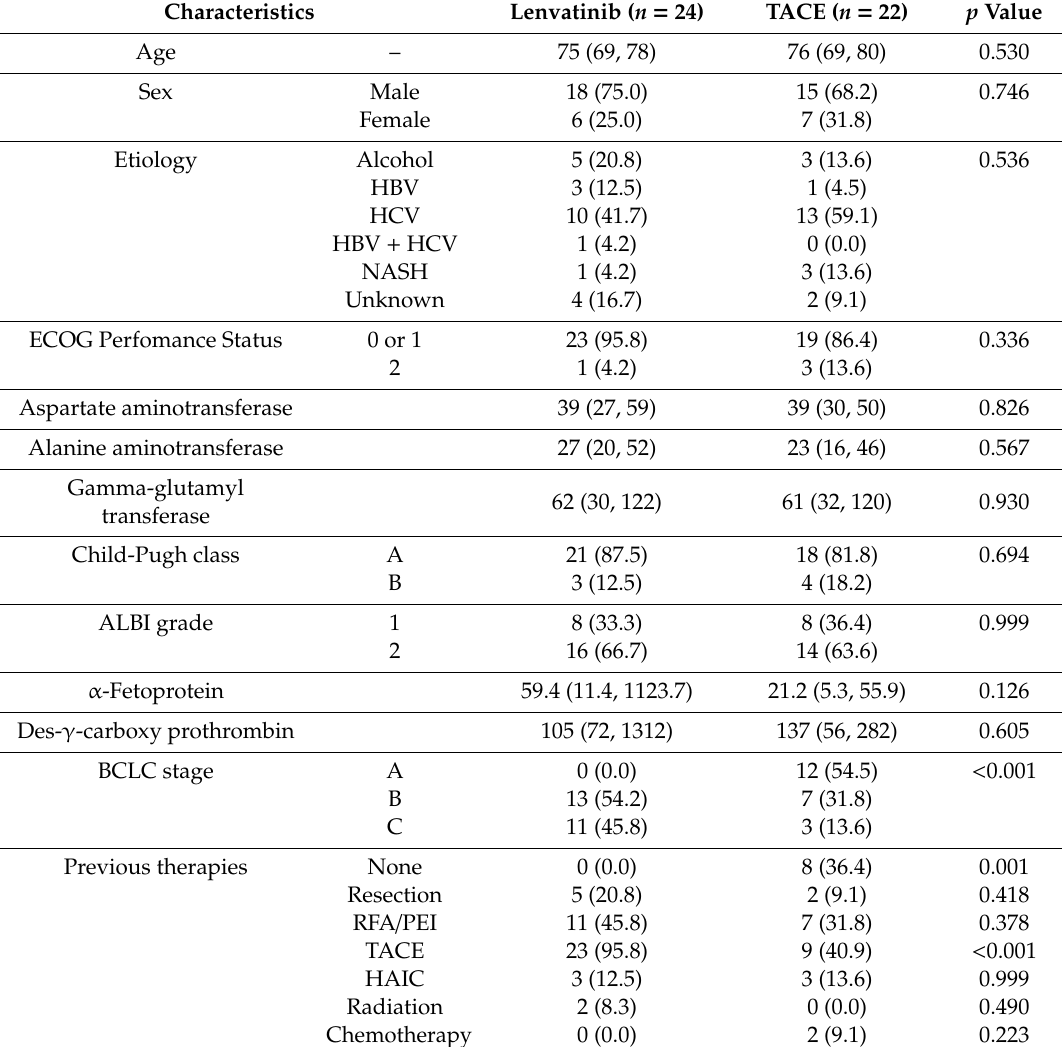
Table 1. Characteristics of hepatocellular carcinoma (HCC) patients at